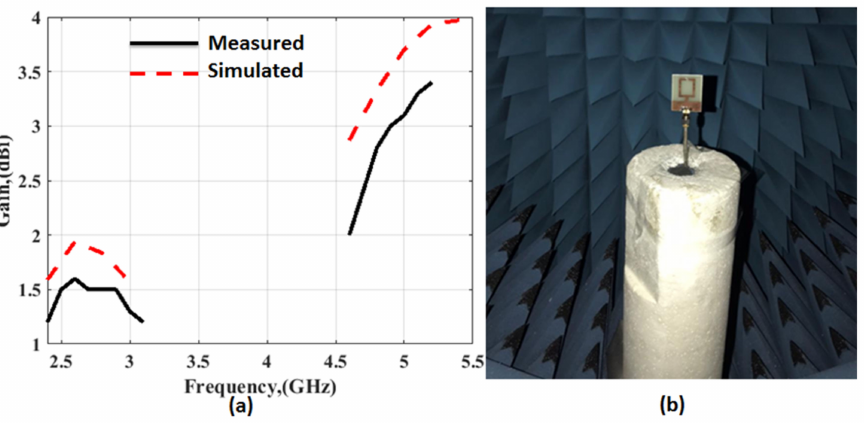
Figure 6. The CPW dual-band monopole antenna: ( a ) Peak gain results; ( b ) radiation pattern measurement